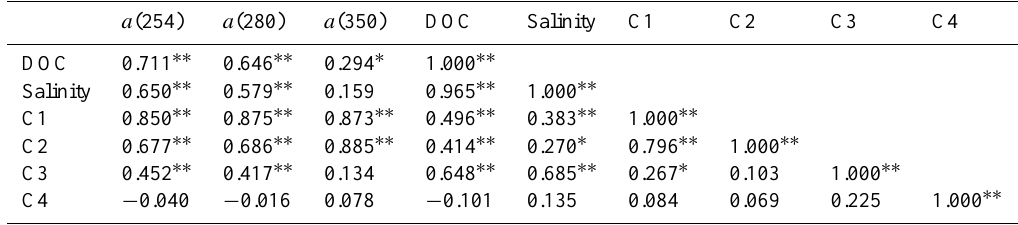
Table 4. Correlation coefficients ( R ) and significance levels ( p) of the linear relationships between CDOM absorption, DOC, salinity and fluorescent